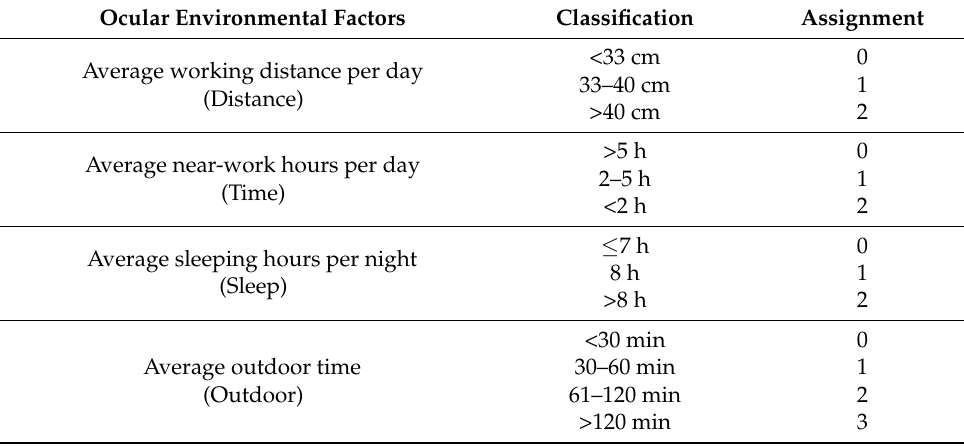
Table 2. The relative ocular environmental factors and